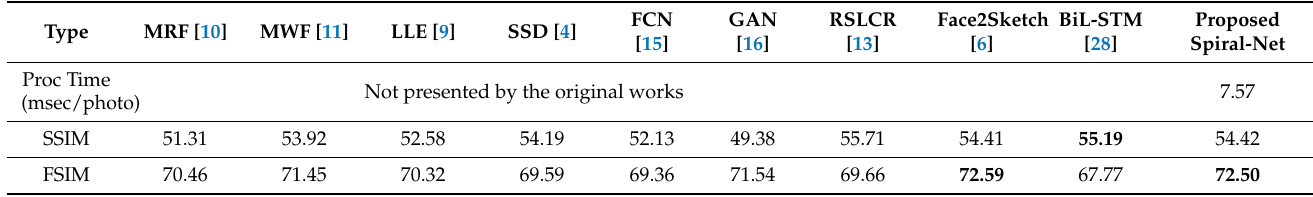
Table 4. Comparison of SSIM and FSIM Values for CUFS.